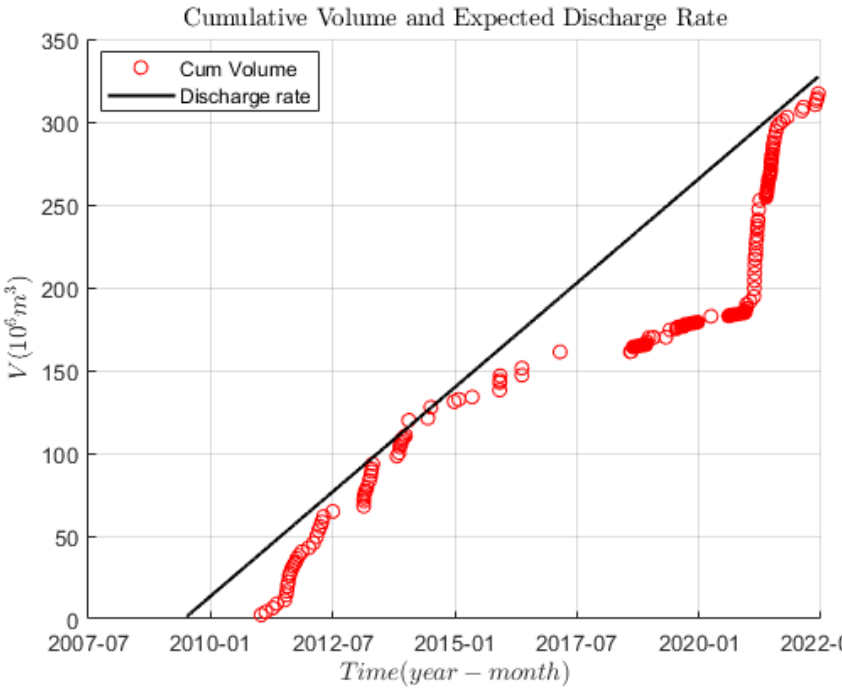
Figure 3. Cumulative volume of lava flows and pyroclastic material (in millions of cubic meters) erupted by Mt. Etna between January 2011 and July 2022 considering both lava fountains and effusive eruptions (red circles), compared to the expected discharge rate (black line) of 0.8 m 3 s − 1 [18]. The values used can be found in the (Supplementary Material, Table S2) in the column “Cumulative Total Volume”. The graph starts from 2009 because it is the updated extension of the graph published by [18].